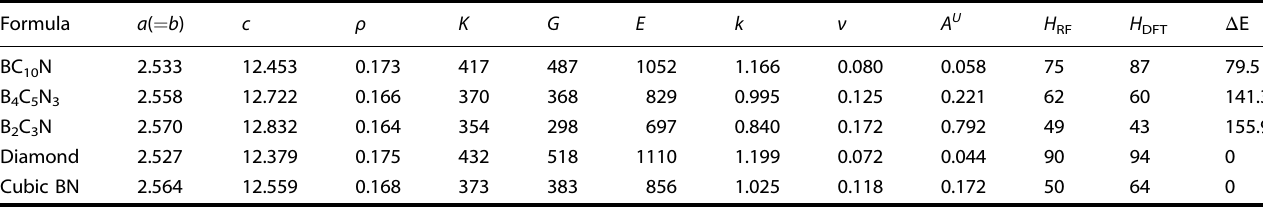
Table 1. Structural and mechanical properties calculated by density functional theory